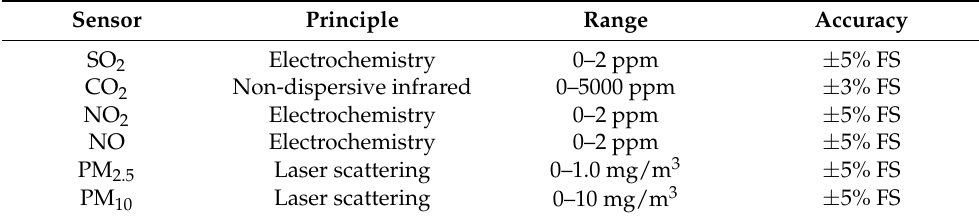
Table 1. Sensor parameters of the device, full-scale